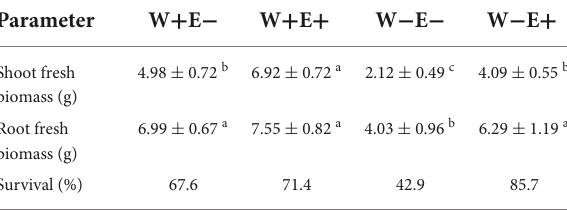
TABLE 1 Shoot and root fresh biomass of strawberry